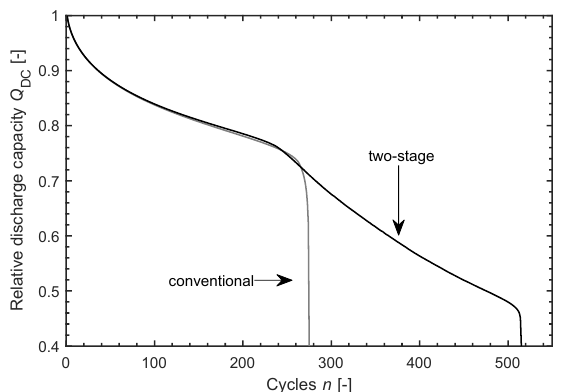
Figure 5. Discharge capacity relative to initial capacity for the cell with two-stage anode porosity. A kink halves the discharge capacity curve, which shows a sudden-death after more than 500 cycles. The previous design with constant porosity is shown in grey for